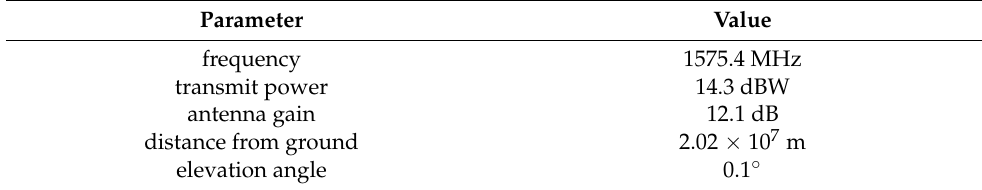
Table 1. Satellite system